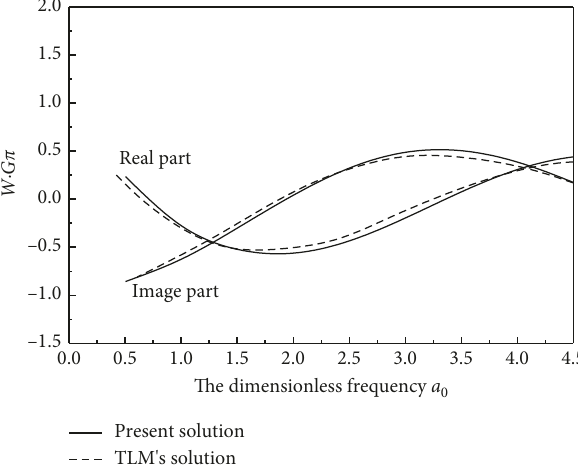
Figure 5: Displacement response of half-space under the harmonic vertical